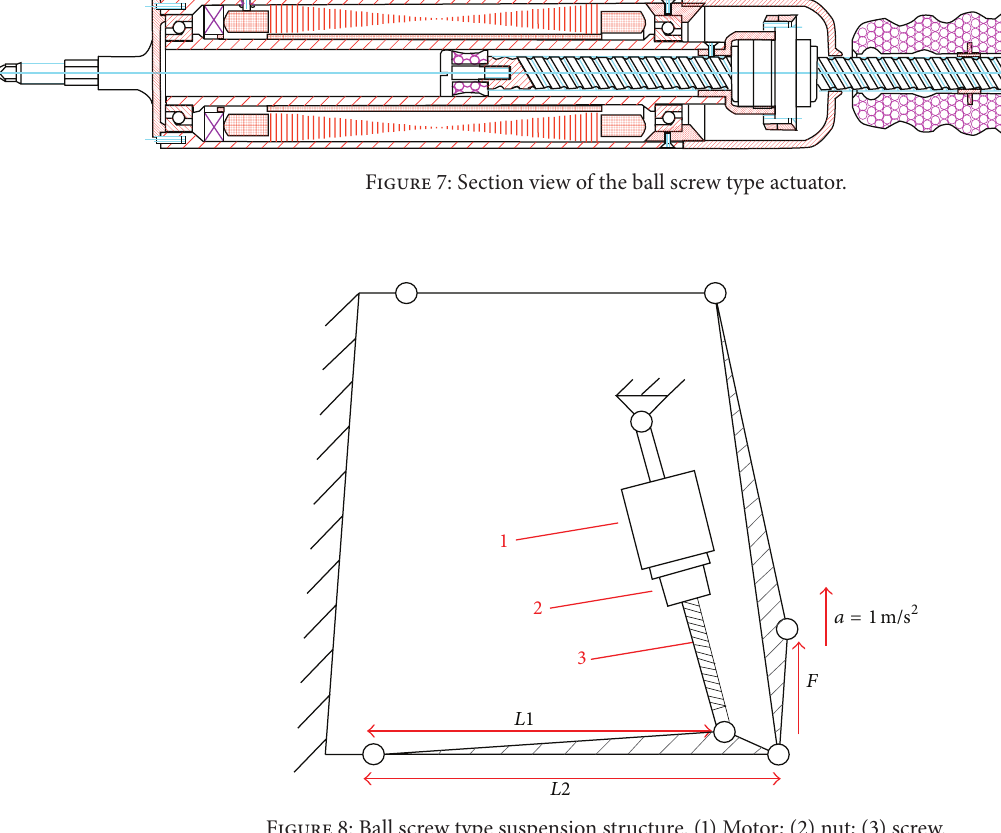
Figure 8: Ball screw type suspension structure. (1) Motor; (2) nut; (3)